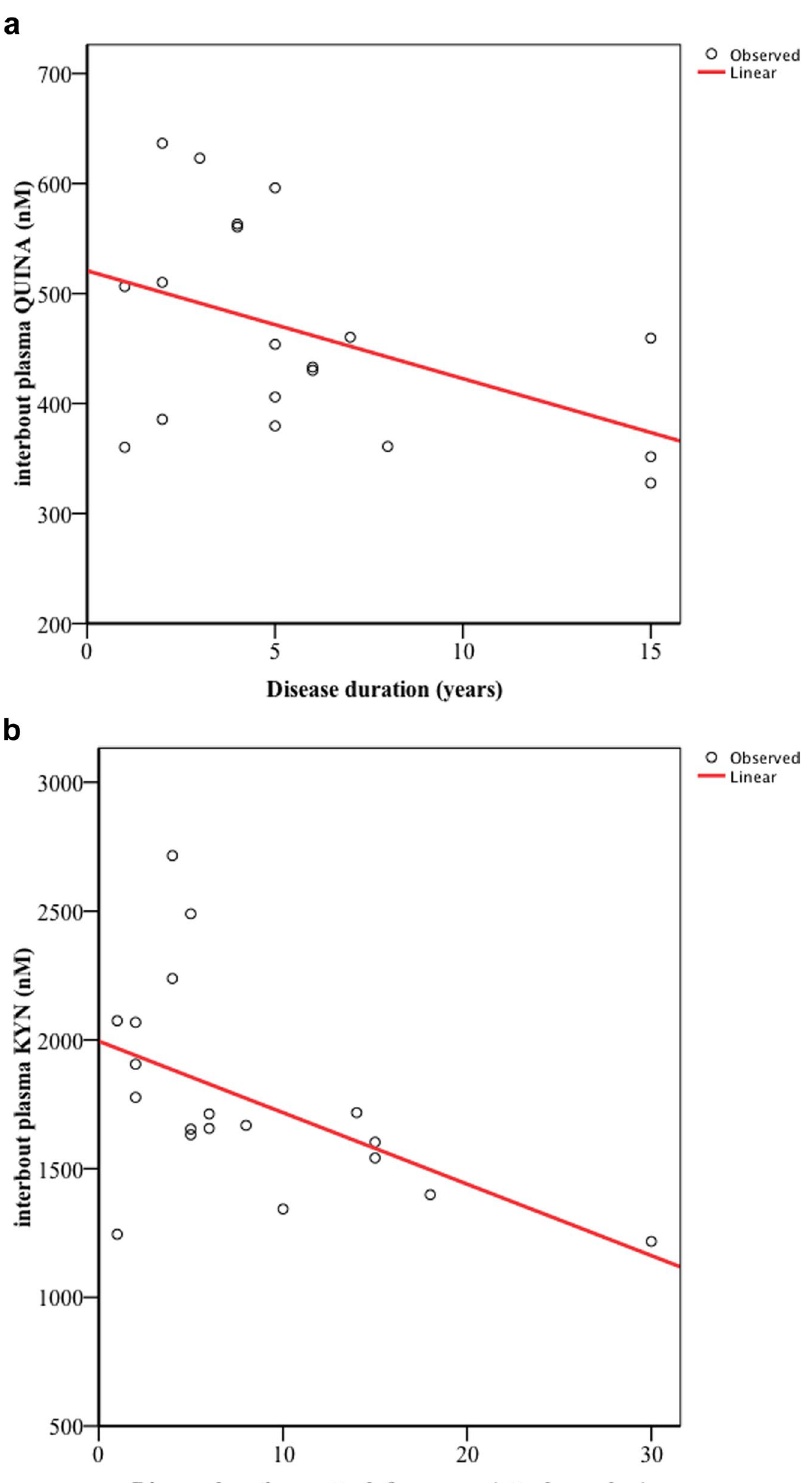
Fig. 3 a and b Significant correlations between the age of healthy controls and plasma levels of Trp, KYNA, 3-HANA and QUINA, as well as the age of CH patients and plasma levels of ictal ANA. Median of data and value of interquartile range were represented in the figures. Trp: tryptophan, KYNA: kynurenic acid, 3-HANA: 3-hydroxyanthranilic acid, QUINA: quinolinic acid, ANA: anthranilic